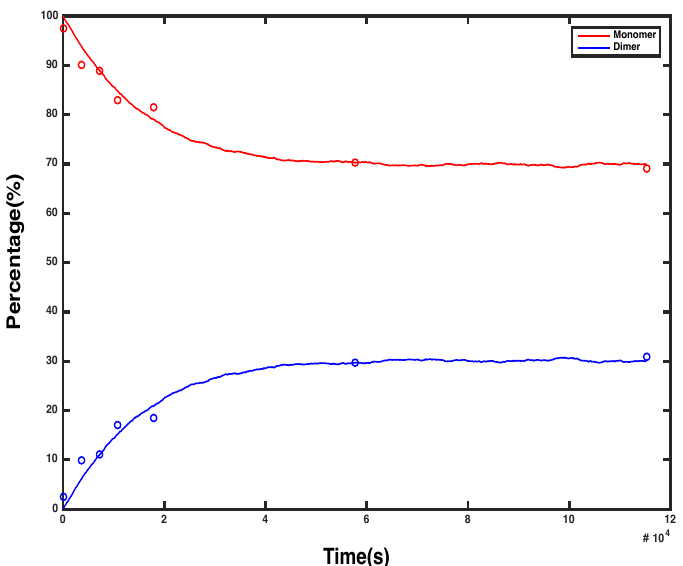
Figure 8. Simulation result of SSA (red and blue lines signifying monomer and dimer, respectively) in comparison with that of AKPE (red and blue empty circles). Apparent correspondence between AKPE and SSA simulation results is